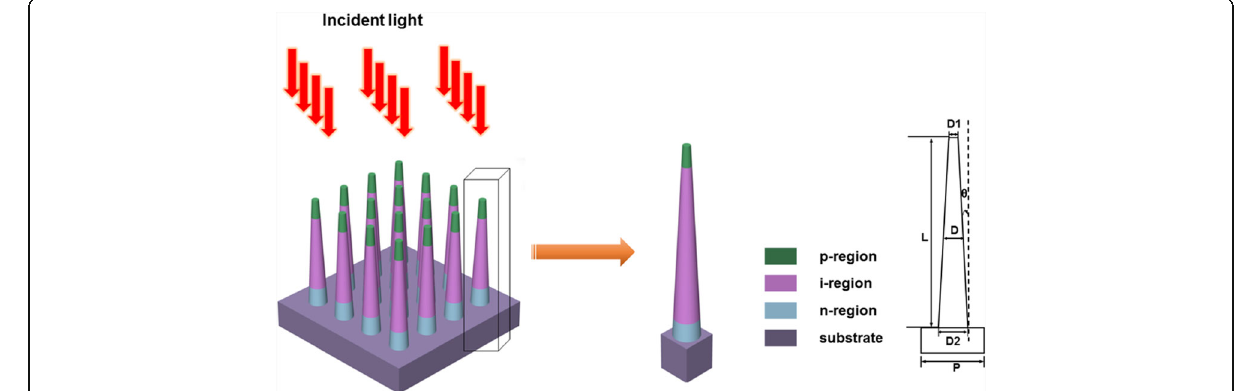
Fig. 1 The schematic diagram of the axial pin junction GaAs nanocone